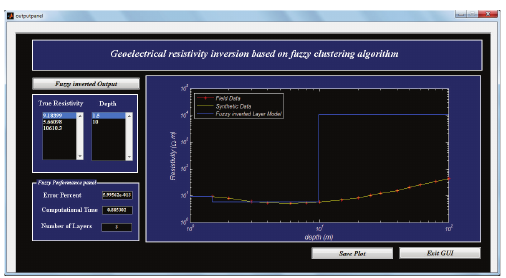
Figure 5: Output panel showing the fuzzy subtractive clustering inverted model for data 1.